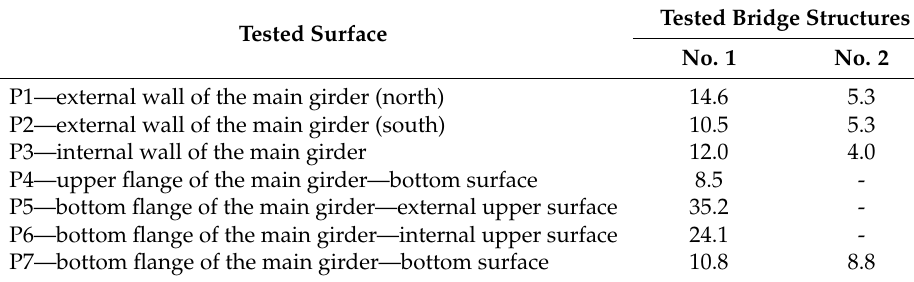
Table 2. Corrosion losses after 1 year of exposure r corr ( µ m · year − 1 ).